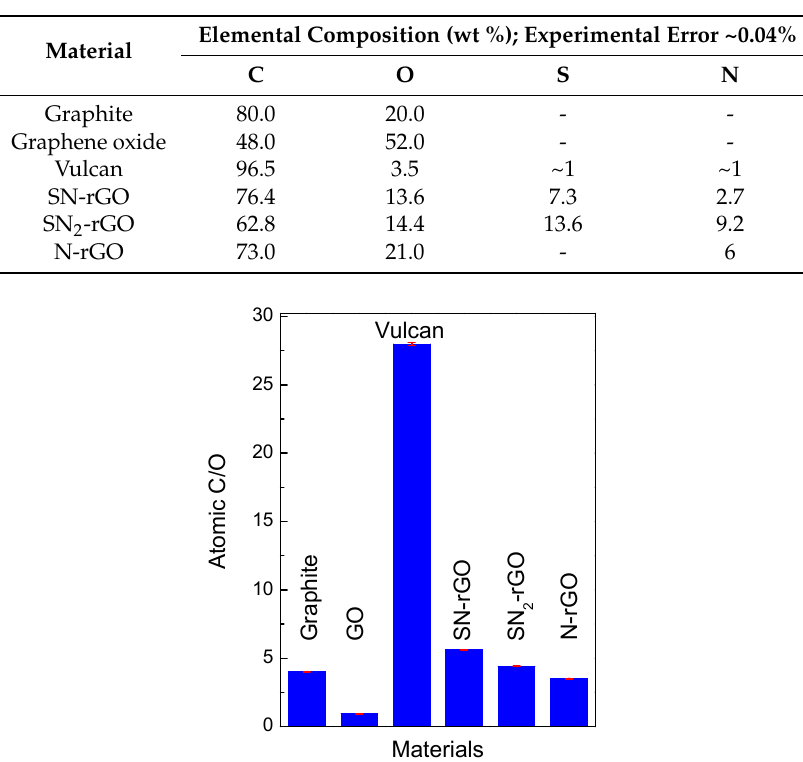
Table 2. Elemental analysis for all studied materials.